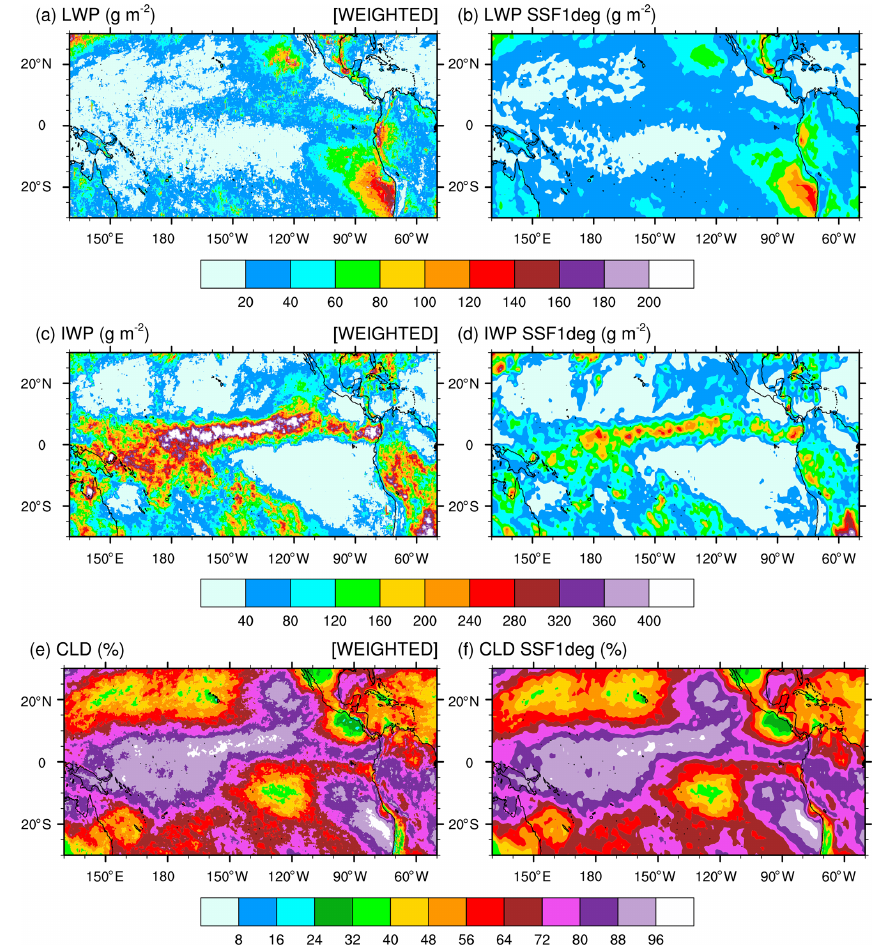
Figure 5. (a, b) Monthly-mean cloudy area-weighted cloud liquid water path (LWP), (c, d) cloud area-weighted cloud ice water path (IWP), and (e, f) cloud fraction (CLD) over the tropical Pacific Ocean for December 2015. Panels (a) , (c) , and (e) are SSF data; panels (b) , (d) , and (f) are SSF1deg climatological